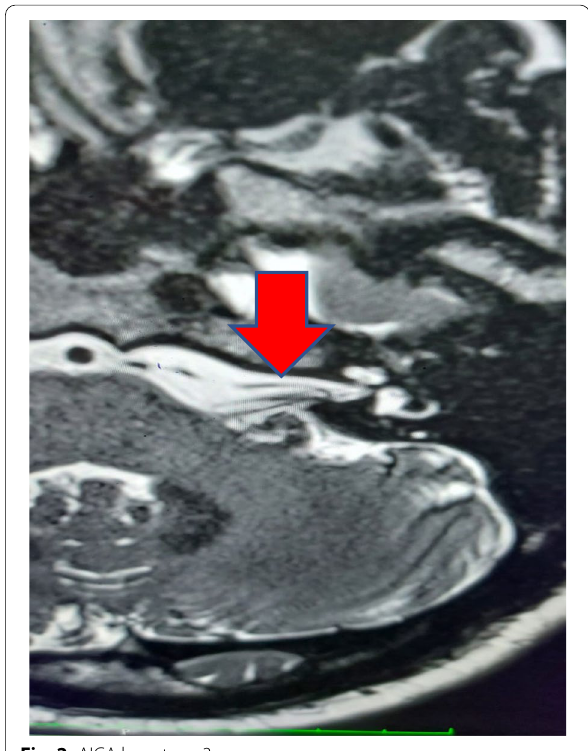
Fig. 2 AICA loop type 3